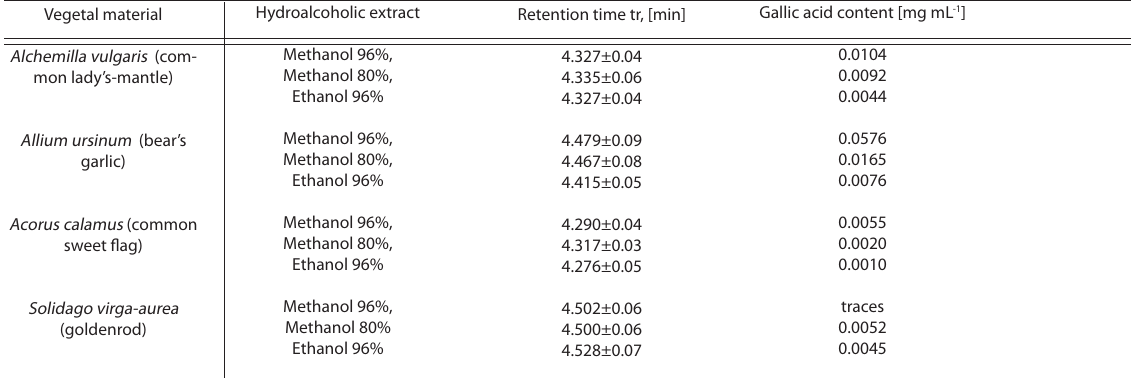
Table 1. Retention times and gallic acid content of the hydro-alcoholic extracts obtained by maceration. Vegetal